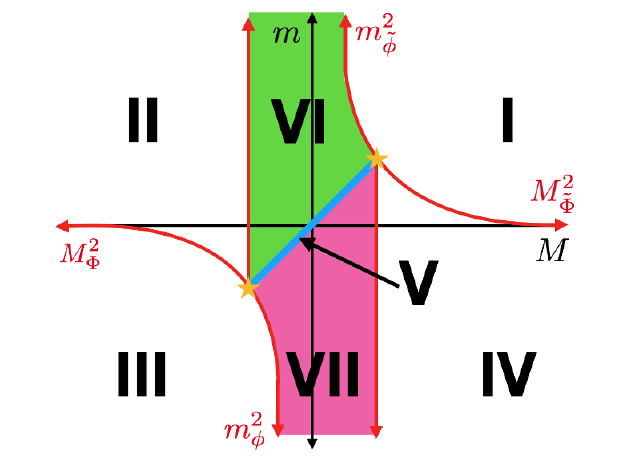
Figure 4 . Phase diagram for (cid:13)avor broken QCD 3 with f < k; F > k . These phases are laid out in section